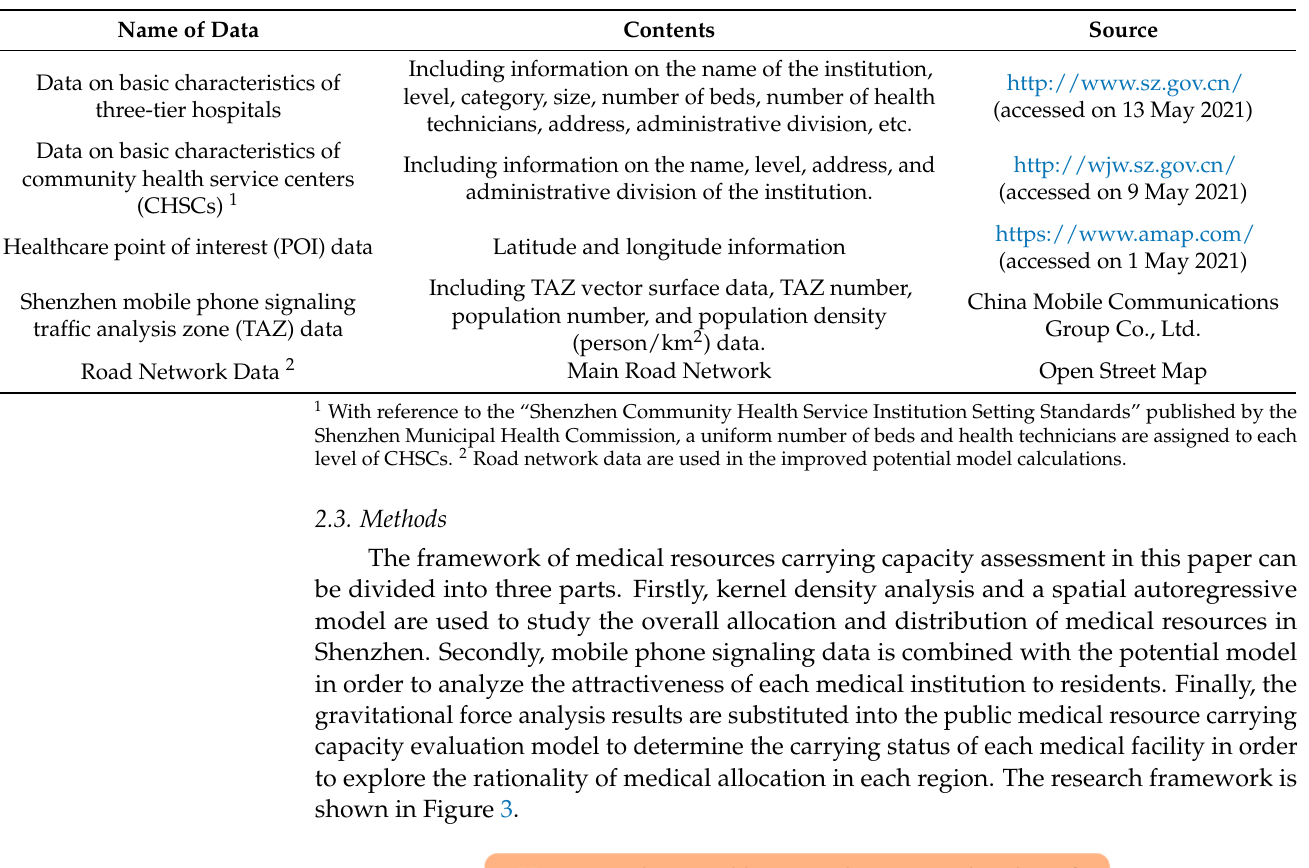
Table 1. Data Sources.